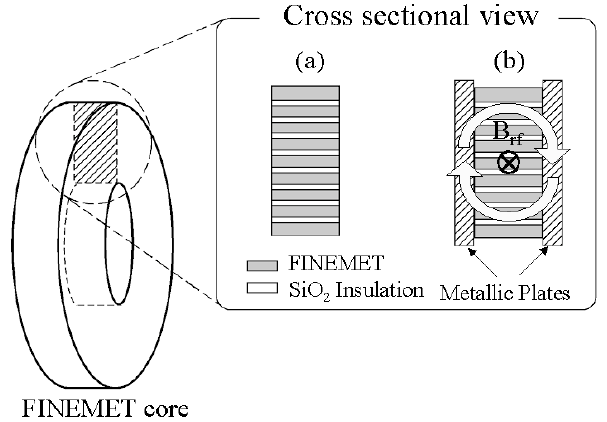
FIG. 4. Schematic description of the impedance reduction. Cross sectional views of (a) a FINEMET core in which every FINEMET ribbon is electrically insulated and (b) a core attached to two metallic plates inducing electrically shorted circuits are shown.